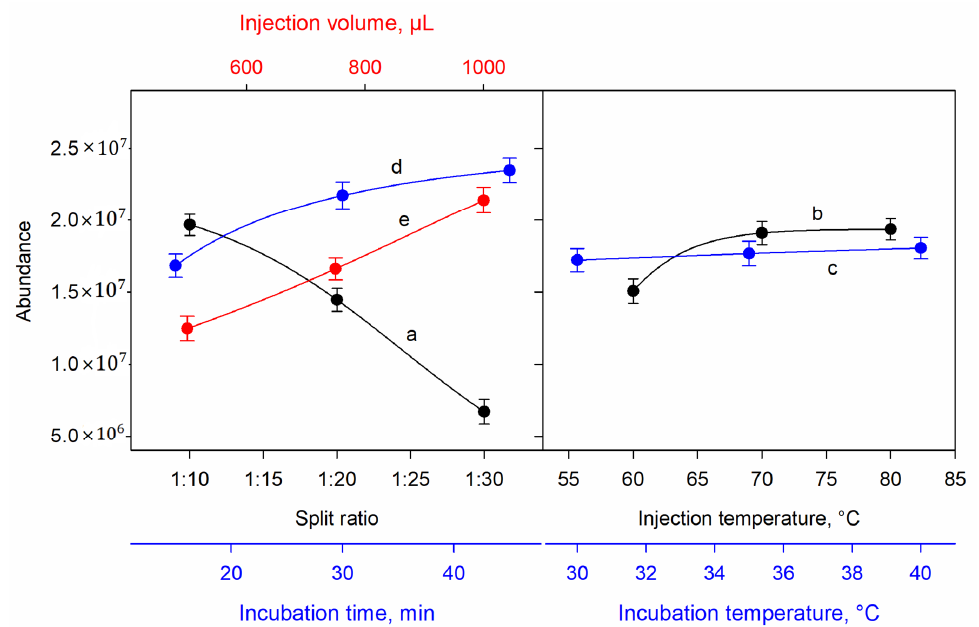
Figure 2. Effect of several experimental variables on the signal measured: ( a ) split ratio; ( b ) injection temperature; ( c ) incubation temperature; ( d ) incubation time; ( e ) injection volume.